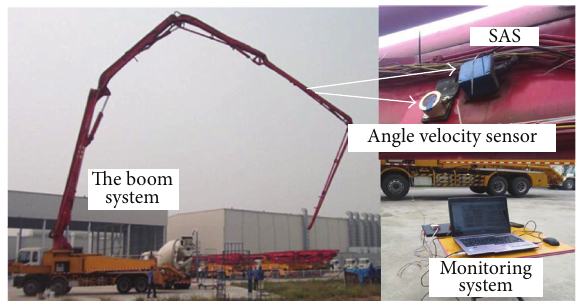
Figure 8: The experimental